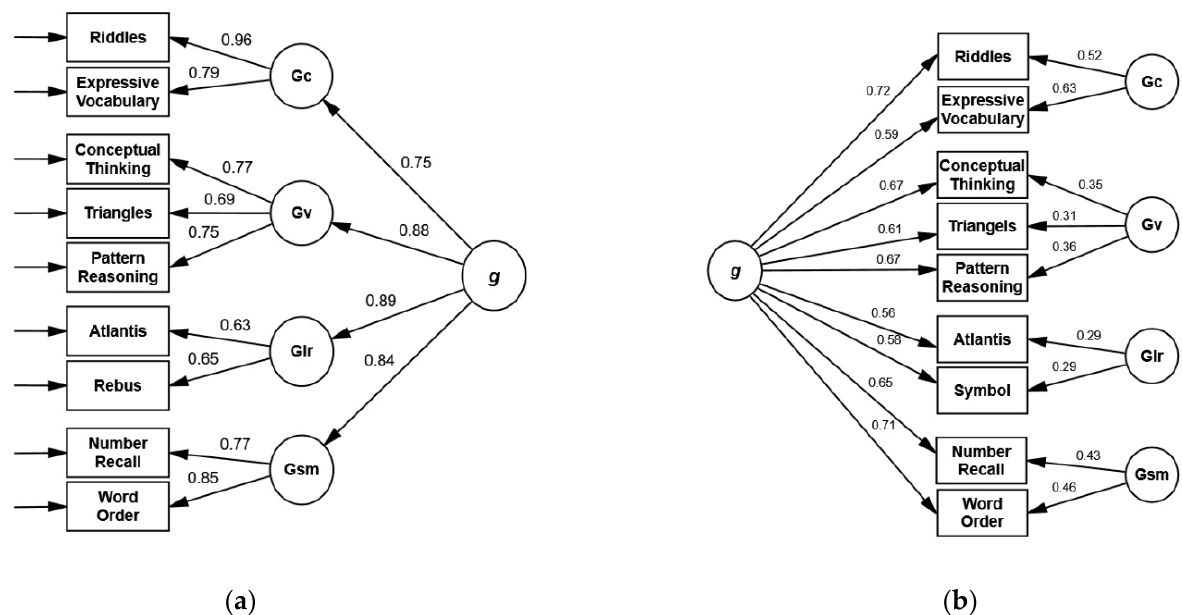
Figure 4. Second-order model ( a ) and bifactor model ( b ) with standardized loading coefficients for the KABC-II CHC core subtest without Rover in the combined sample of 5- and 6-year-olds. ( a ) χ 2 = 31.70, df = 23, p = 0.107, CFI = 0.995, RMSEA = 0.029, SRMR = 0.022. ( b ) χ 2 = 32.33, df = 23, p = 0.094, CFI = 0.995, RMSEA = 0.030, SRMR = 0.022.